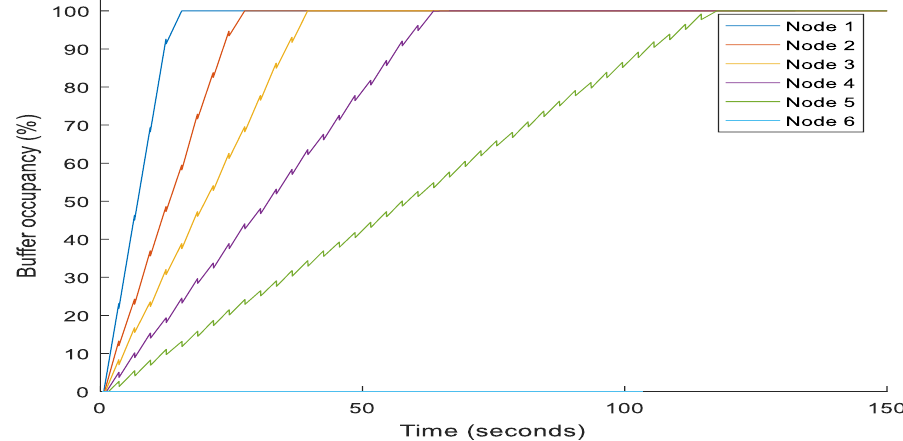
Figure 9. Buffer occupancy with NoDCCP at 0.5 Mbps.